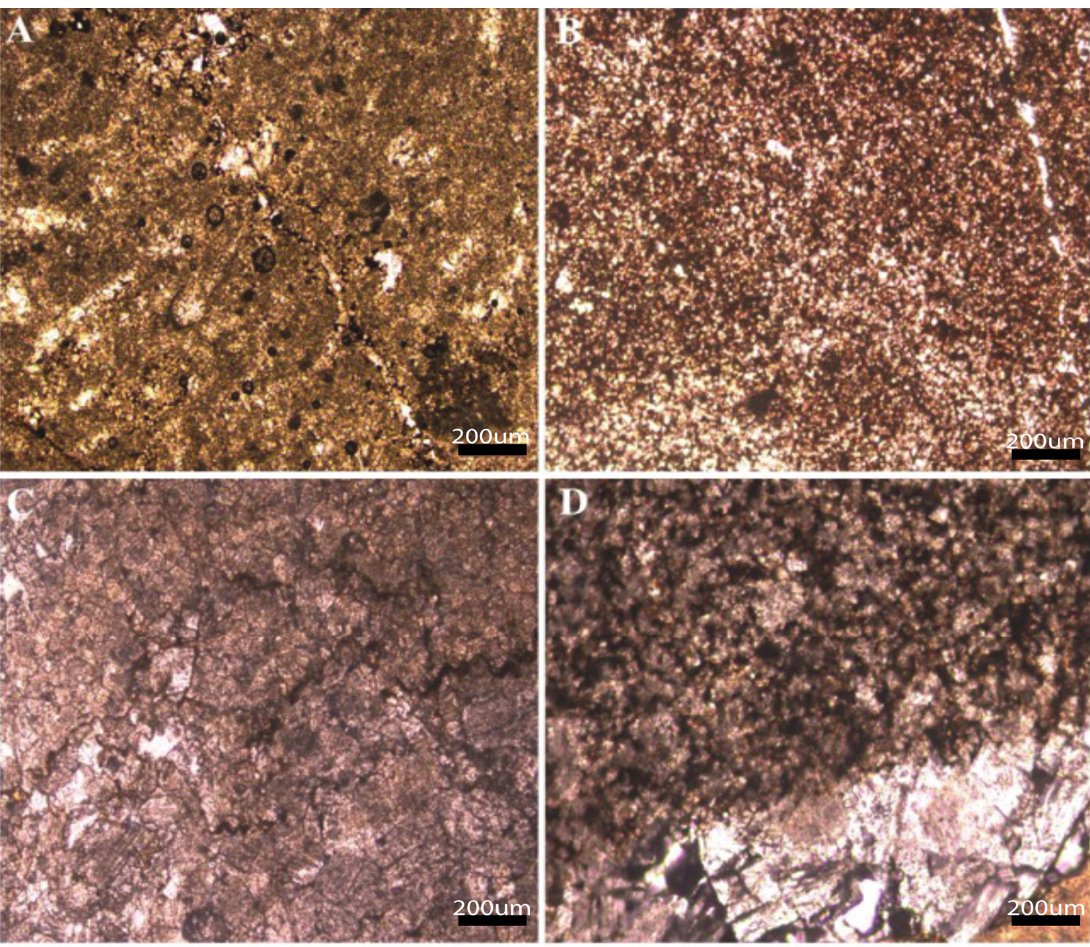
Figure 7. Photomicrographs of: ( A ) Host limestone of the Qamchuqa Formation, showing the dissolution-precipitation of moldic porosity, see the middle part of the photo which shows a low amplitude pressure solution structure. ( B ) preservation of precursor limestone even a slight diagenesis is observed, close up the lower right part of the photo (initiation od pressure solution structure). ( C ) High amplitude stylolite cross cut early dolomite crystals. ( D ) The boundary between host limestone and fracture filling coarse crystalline dolomite.